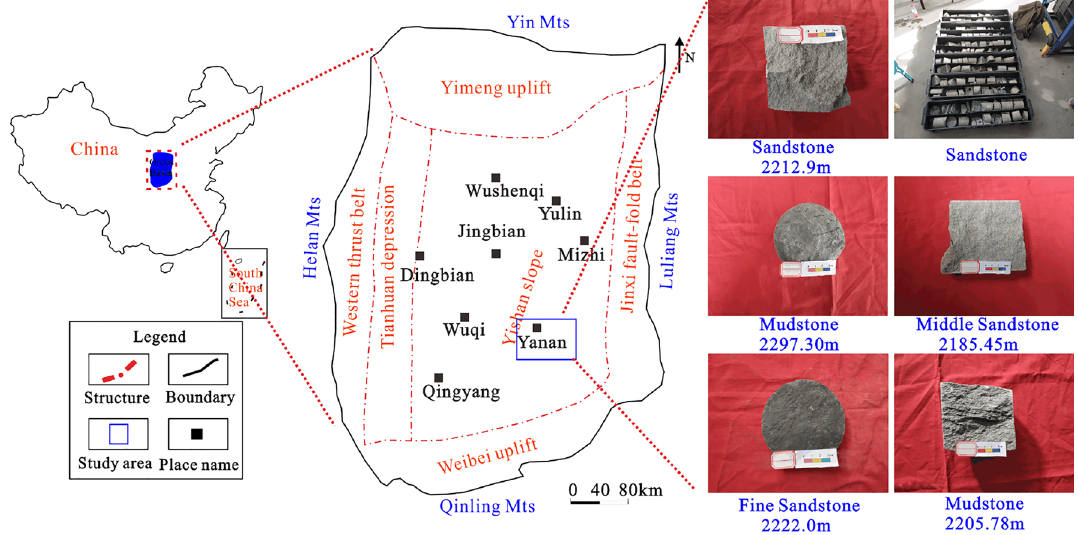
Fig. 1 Location map of Yan'an gas field in Ordos